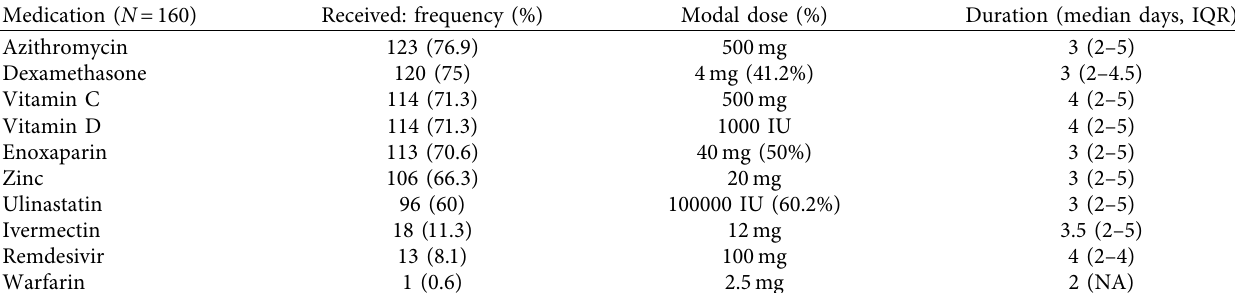
Table 3: Treatment modalities administered to patients admitted at case hospital.